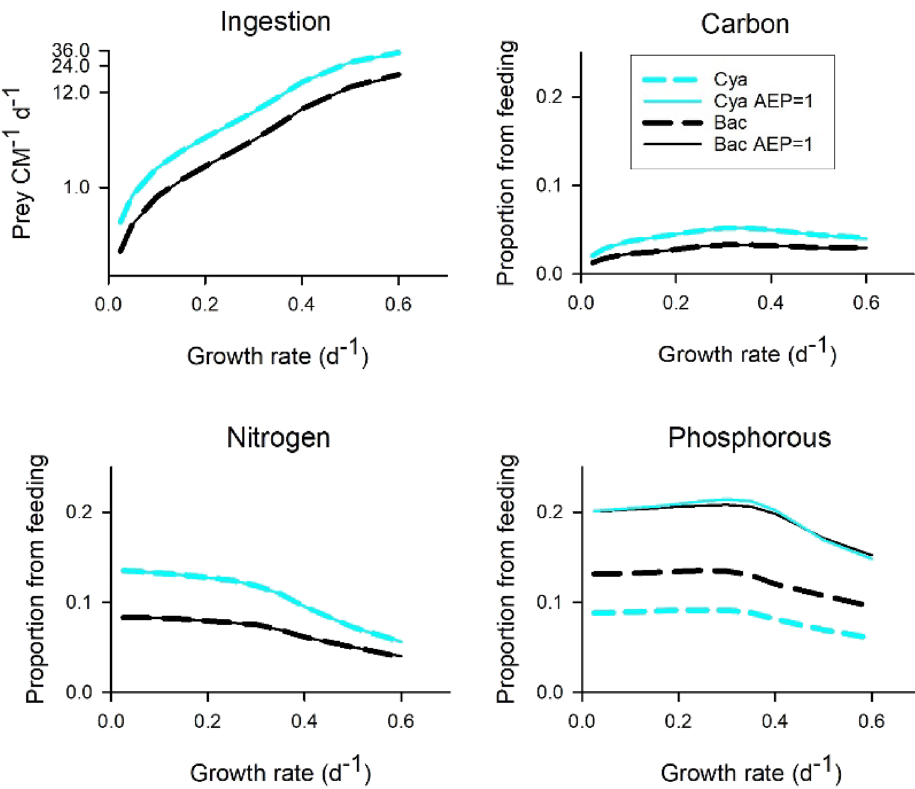
Figure 6. Ingestion rates and fates of ingested prokaryote of different C:N:P stoichiometry into a mixoplankton. The system contained a total resource of 70 mgN m −3 at a mole N:P = 16, and with 20% of the P supplied as prokaryote picophytoplankton ‘cyanobacteria’ (Cya; C:N:P of 60.6:14:1) or as bacteria (Bac; C:N:P of 29.4:7.1:1). The growth rate equates to the chemostat dilution rate at steady-state; the resource regime drives N-limiting growth of the mixoplankton. The default (dashed lines) assumes the assimilation efficiency for P is the same as N (AE P = AE N = 0.8); also shown are the consequences of assuming AE P = 1 (AEP=1). Plots show, as 24 h averages, the ingestion rates, and the proportion of C, N and P derived from prey assimilated into mixoplankton. See Table S1 for stoichiometric values and Fig. S9 for residual prey